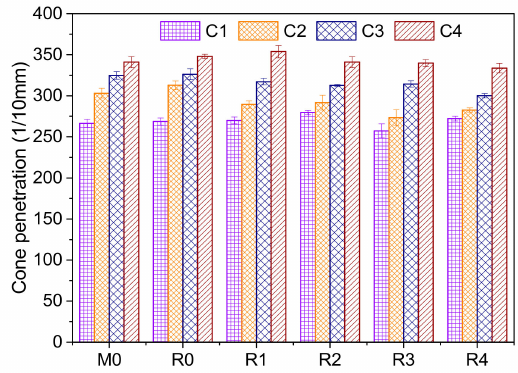
Figure 10. Cone penetration test results of sealing